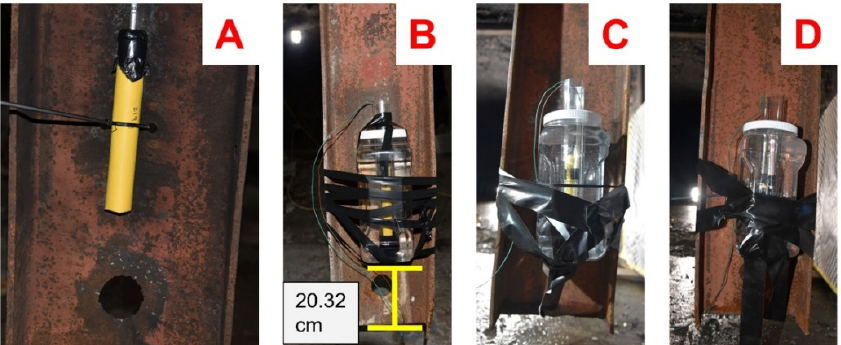
Figure 3. ( A ) Traditional dynamite charge attached to the column ( B ) Dynamite water charge attached to the column ( C ) Half dynamite water charge attached to the column ( D ) Quarter dynamite water charge attached to the column.